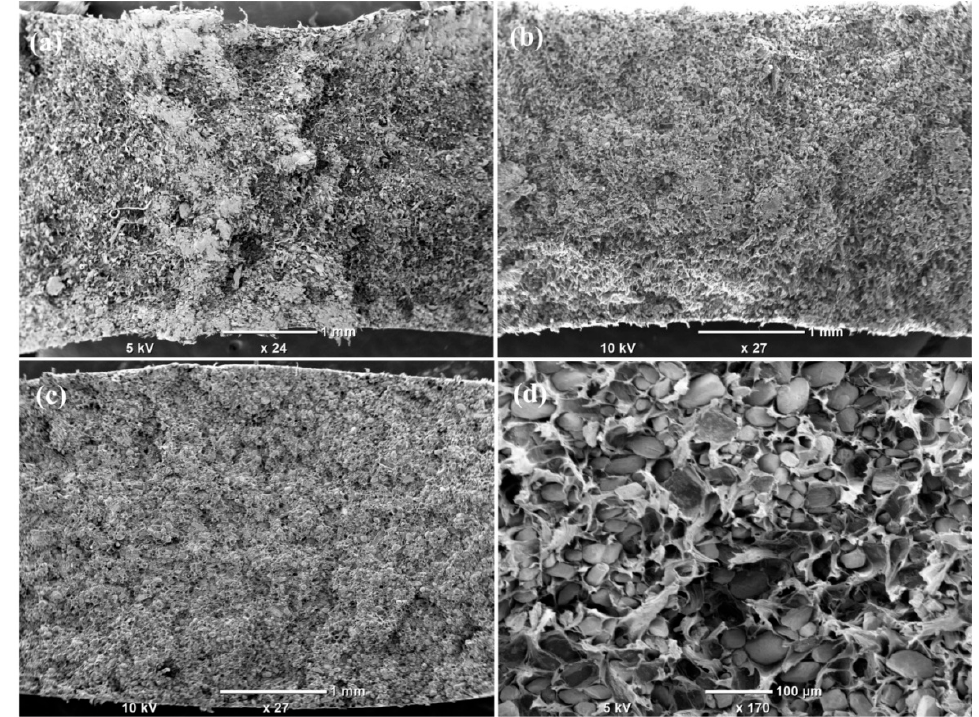
Figure 9. SEM micrographs of ( a ) tensile, ( b , d ) flexural, and ( c ) impact test-fractured MP-PP composites.